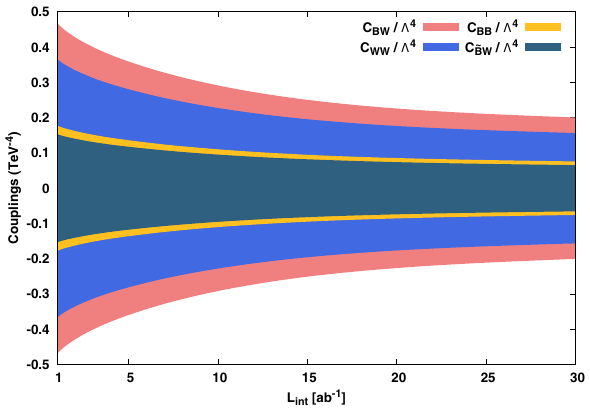
Fig. 10 Estimated sensitivity on aNTG couplings at 95% C.L. without systematic error as a function of integrated luminosity where there is only one coupling varied at a time from its SM value